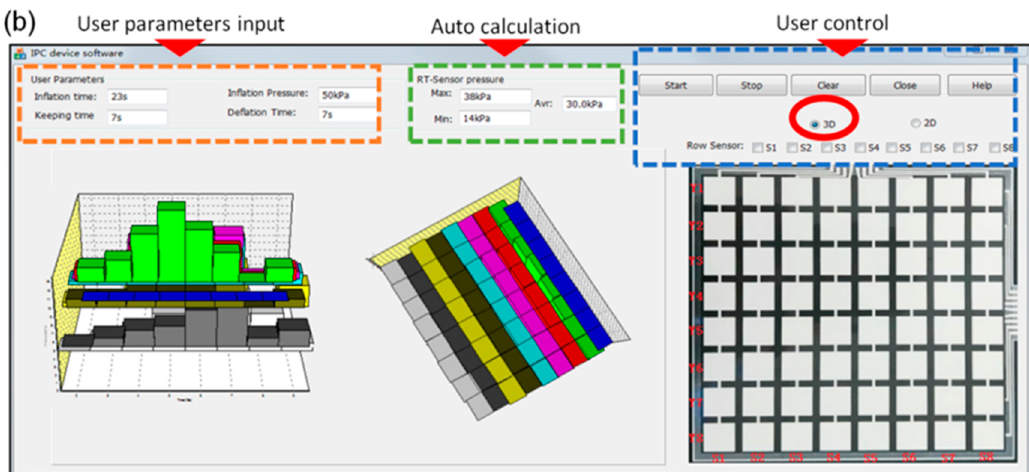
Figure 10. The user interface displaying the developed software of IPC dynamic pressure monitoring system. ( a ) 2D display on the detected skin (interface) pressure along one column of the soft sensor array in three inflation-deflation cycles; ( b ) 3D real-time display of all cells (64) (eight columns of the soft sensor array) and partial cells in colorful tetrahedrons. .